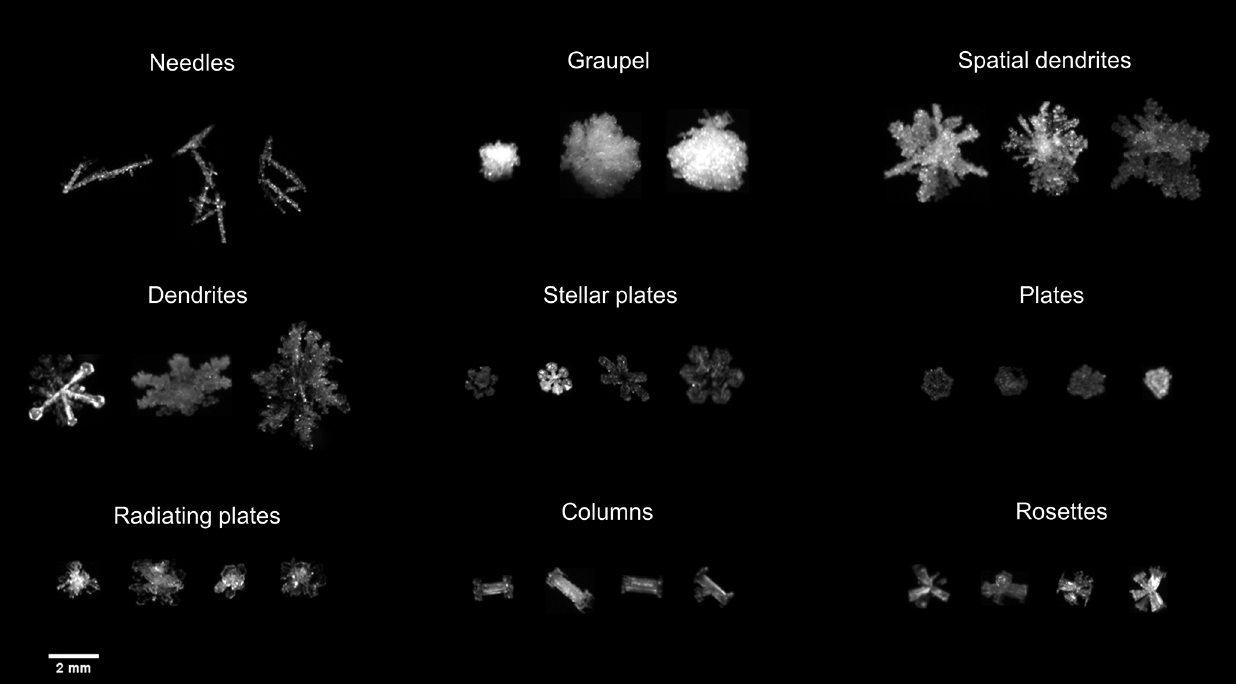
Figure 2. Some examples of single, specifiable ice particles captured by the MASC, and their shape. Needles were only captured as aggre-